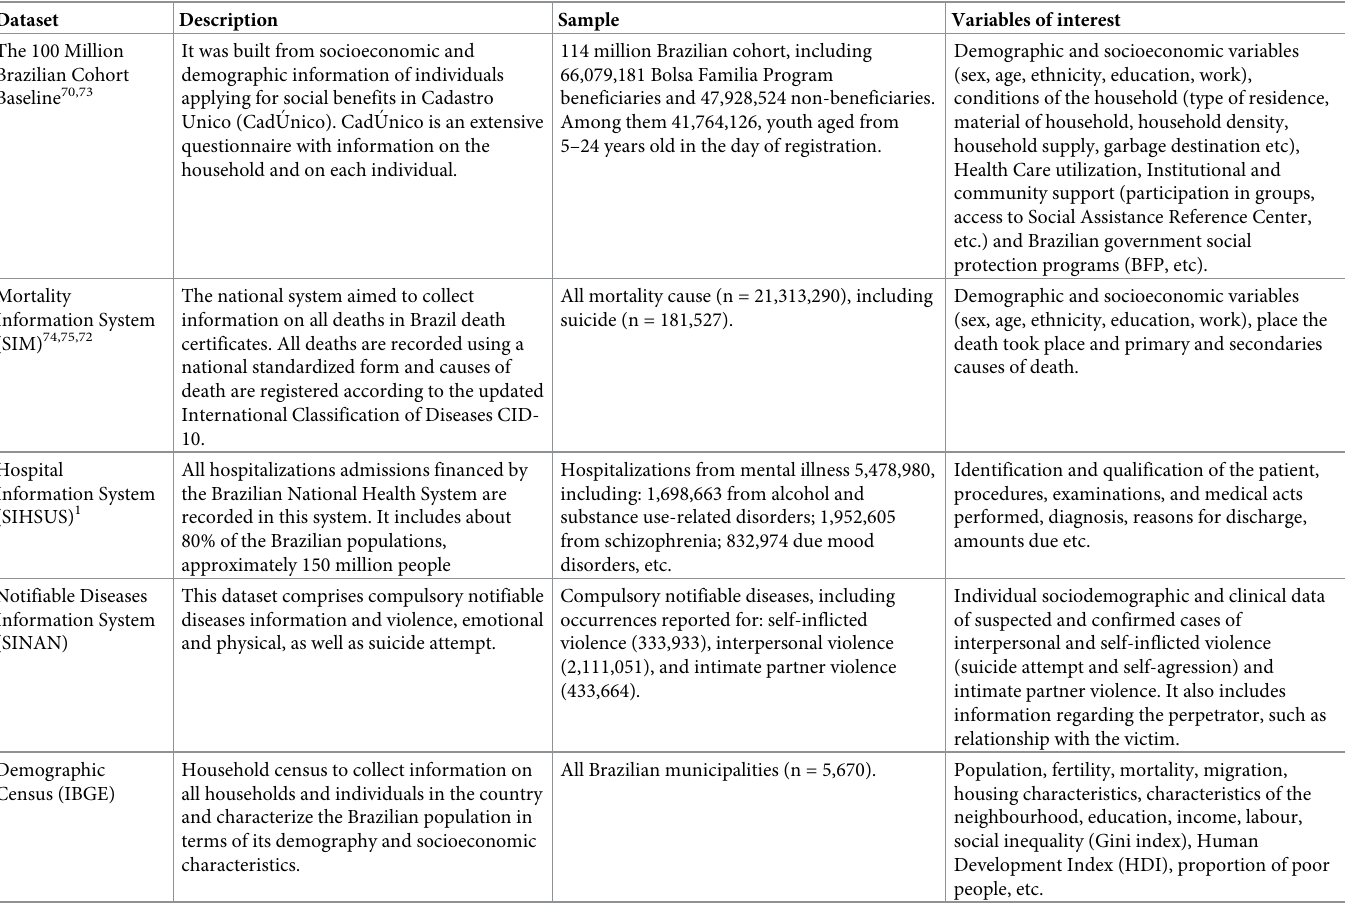
Table 1. Summary of the dataset’s description, from 2001 to